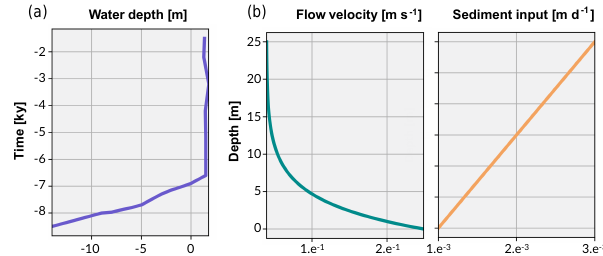
Figure 4. The curve in (a) shows the Holocene sea-level curve es- timated from Sloss et al. (2007). The graphs in (b) illustrate the boundary conditions established for flow velocity and sediment in- put used in the experimental